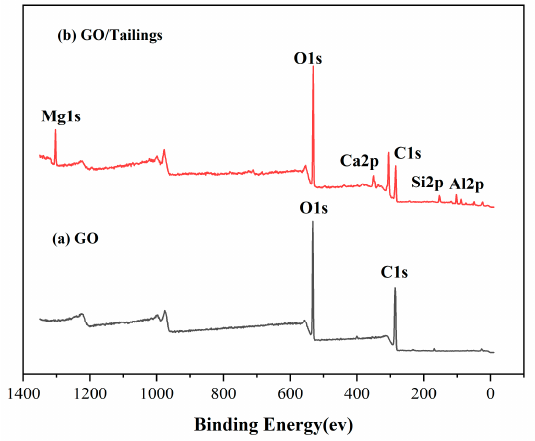
Figure 5. XPS spectra of GO ( a ) and GO/iron tailings ( b ).